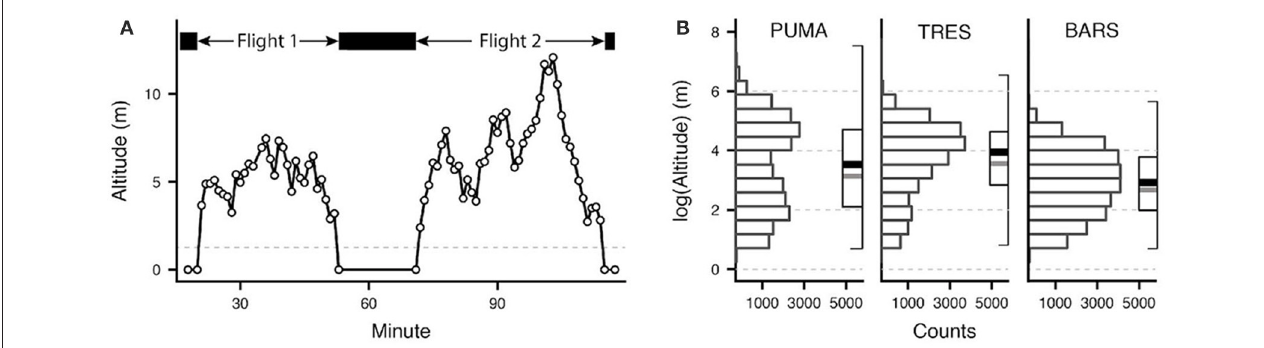
FIGURE 1 | Determination of individual flight bouts and distribution of flight altitudes. In subfigure (A) , we considered multiple consecutive data points above an altitude threshold of 2m (gray dashed line) as an individual flight bout. In the second set of subfigures (B) , altitude data from all recorded flight bouts is presented as a histogram and a combined boxplot with the median (thick black line) and the mean (thick gray line). The outer edges of the box represent the IQR.